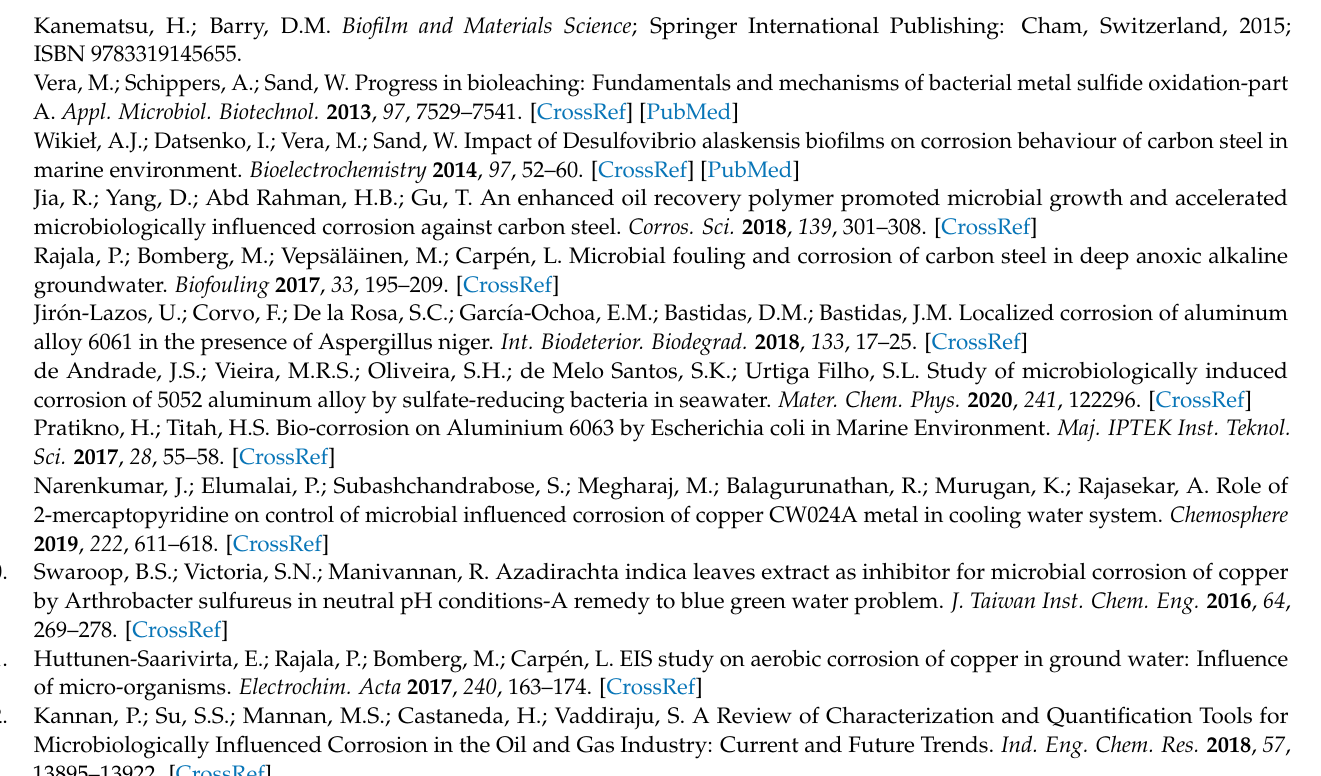
metallidurans . Figure S2: Roughness analysis of STM images of: (a), (b) uncoated Au samples and (c), (d) graphene-coated Au samples, after bacterial exposure. Figure S3: Large area STM image of uncoated Au samples after exposure to C. metallidurans (2.2 µ m × 2.2 µ m, I = 0.05 nA, V = 1 V). Figure S4: Height profile of Au grains found in uncoated Au samples exposed to Cupriavidus